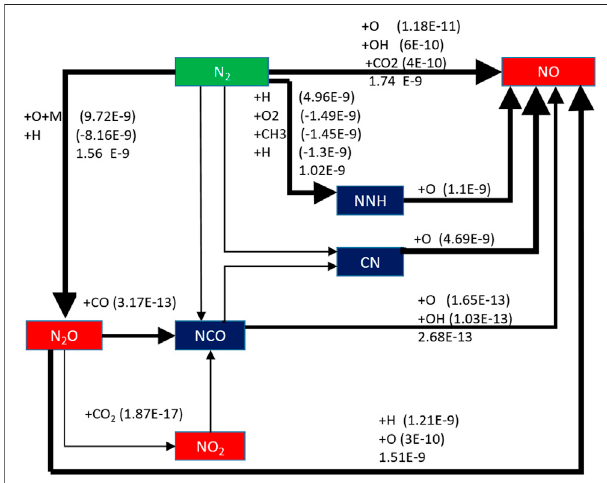
FIGURE 15 | NO generation path after preheat treatment.